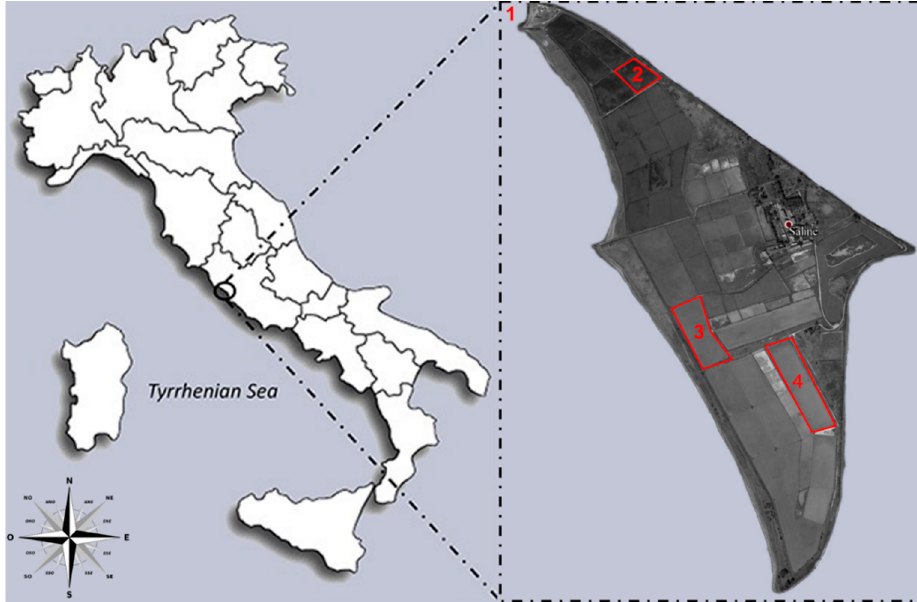
Figure 1. Detailed map of the “Saline di Tarquinia” (Viterbo, Italy) marine salterns with indication of the sampling sites. 1 = S, sea; 2 = P5, low-salinity concentrator pond; 3 = P24, intermediate-salinity concentrator pond; and 4 = P37, crystallisation pond. The map was generated using Google Earth Pro version 7.3.1 and graphically edited.